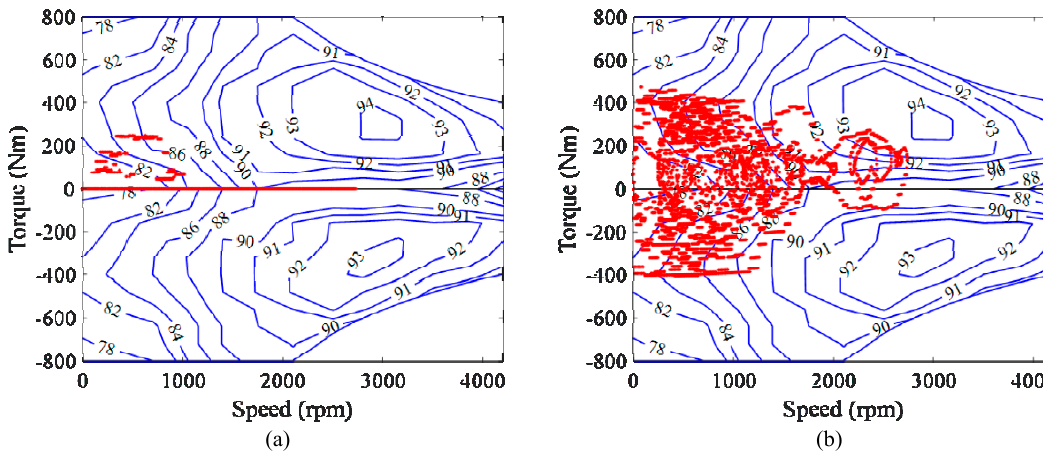
Figure 4. CEM working points. ( a ) Front CEM. ( b ) Rear CEM.